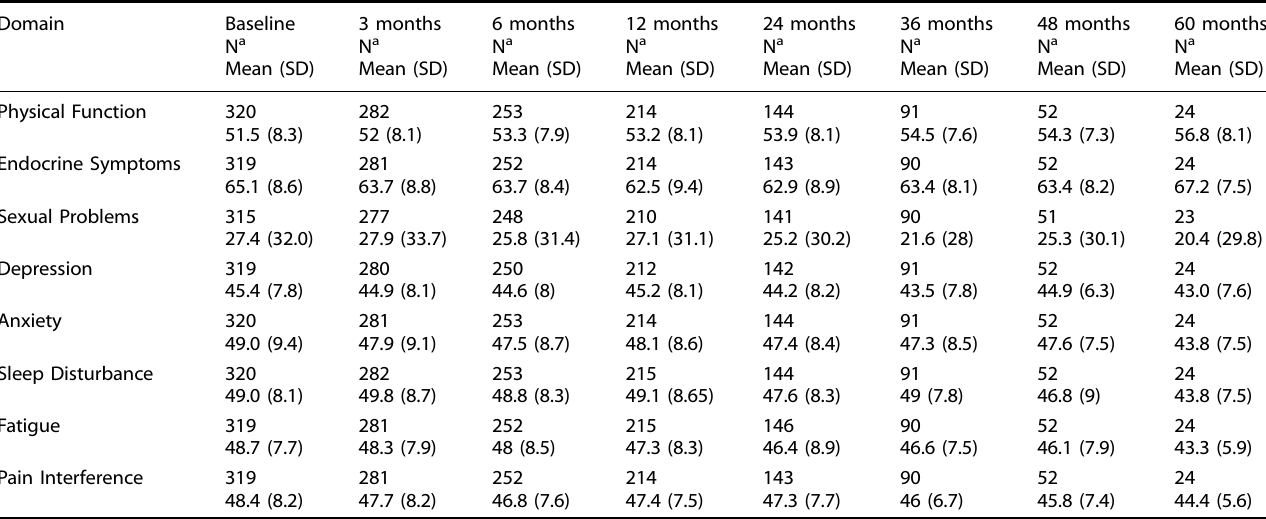
Table 2. Mean scores on patient-reported outcome measures at each study time